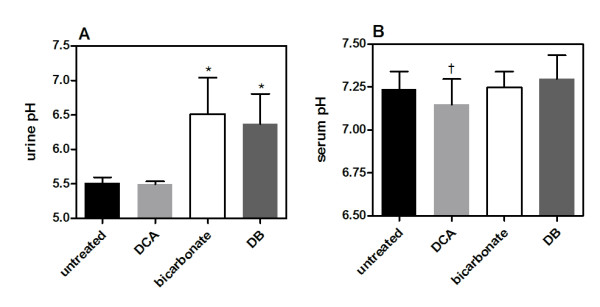
Comparison of urine and serum pH in treatment groups. A) Urine samples were collected from tumor bearing mice at eight different time points over a 3 week period from 3-10 mice in each treatment group. At time zero before starting treatment, urine pH in all groups averaged 5.59 ± 0.2 with no statistical difference between groups. The first collection time after starting treatment was at 24 hours. Urine pH measurements from all collection times were averaged. Asterisks (*) designate average urine pH values that were statistically significant from untreated mouse group by student's two-tailed t-test (p < 0.001). The cross (†) designates average urine pH values between the DCA and DB treated groups were statistically significant (p < 0.03). B) Serum pH was measured in euthanized mice. Differences in serum pH between groups were not statistically significant. Error bars are expressed as SEM.